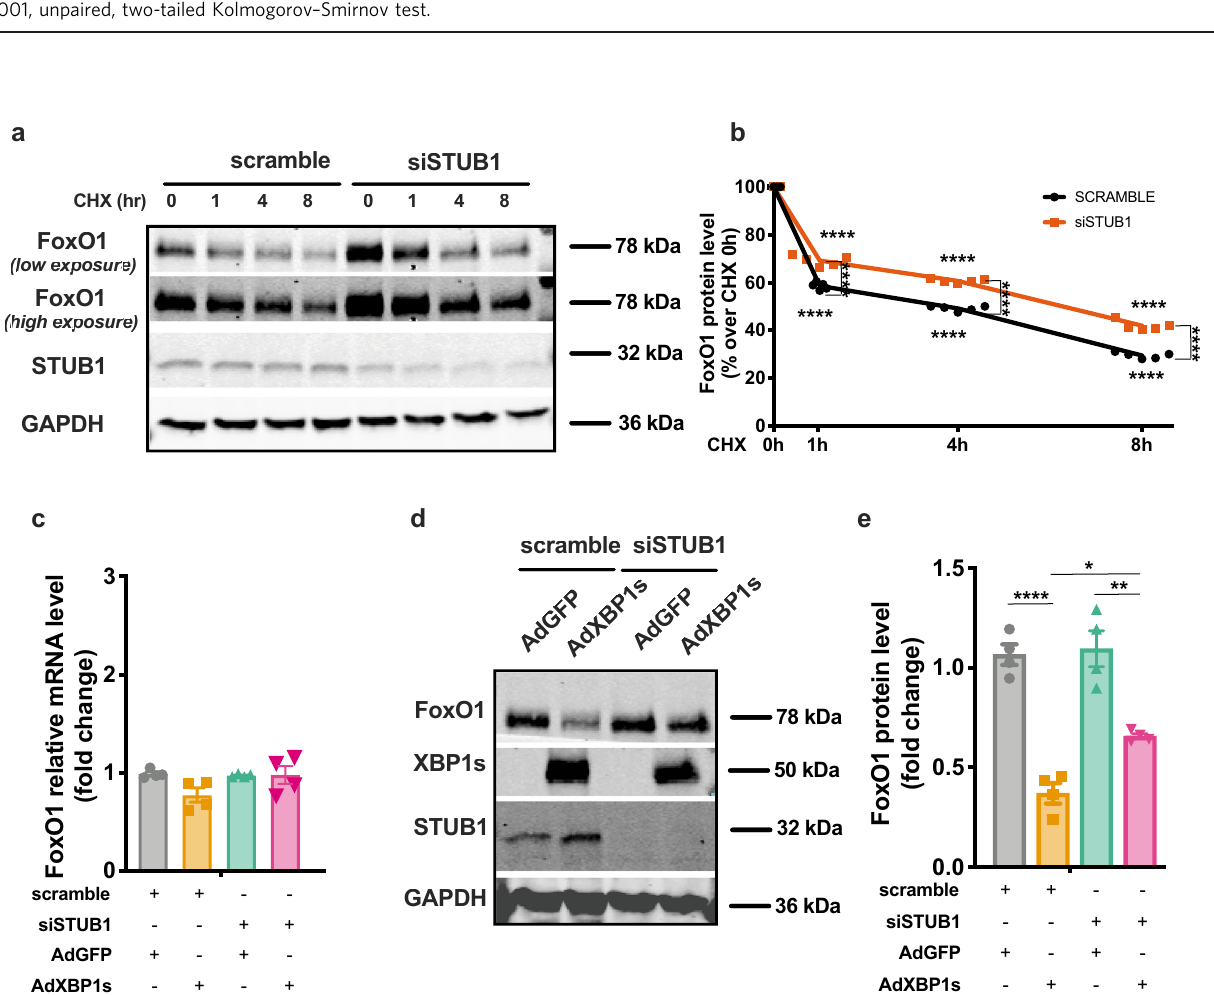
Fig. 4 STUB1 is a direct transcriptional target of Xbp1s. a Conserved consensus sequence of Xbp1s-binding site (unfolded protein response element — UPRE) in the promoter region of STUB1. 129 bp from the transcriptional start site (arrow). b Luciferase (Luc) activity in human embryonic kidney 293 cells (HEK293) transfected with STUB1-luciferase reporter construct (STUB1-Luc) and transduced with the increasing multiplicity of infection of AdGFP or AdXbp1s ( n = 6 biologically independent experiments). c Electrophoretic analysis of chromatin immunoprecipitation (ChIP) assay of STUB1 promoter in NRVMs transduced with AdGFP or AdXbp1s. ChIP was performed with either control mouse immunoglobulin G (IgG) or anti-Xbp1s antibody. PCR was conducted with primers spanning the UPRE site. Images are representative of 4 independent experiments. d Densitometric analysis of STUB1 ChIP band intensities in the different experimental groups ( n = 4 biologically independent experiments). e mRNA level of STUB1 in NRVMs transfected with STUB1- speci fi c small interfering RNA (siSTUB1) or scrambled siRNA control and transduced with AdGFP or AdXbp1s ( n = 4 biologically independent experiments). f Representative immunoblot images of Xbp1s, STUB1 and GAPDH proteins from NRVMs transfected with siSTUB1 or scrambled siRNA control and transduced with increasing multiplicity of infection of AdGFP or AdXbp1s. Images are representative of fi ve independent experiments. g Densitometric analysis of STUB1 protein band in the different experimental groups ( n = 5 biologically independent experiments). h Representative immunoblot images of Xbp1s, STUB1, and GAPDH proteins from LV of WT and Xbp1s TG mice. High and low exposure (high/low exp). Images are representative of six hearts/group. i Bar graphs depicting STUB1 protein band intensities in WT and Xbp1s TG LV samples ( n = 6/group). j mRNA level of XBP1s and STUB1 in LV of CTR and HFpEF hearts ( n = 4 for Xbp1s CTR group; n = 6 for the remaining groups). Results are presented as mean ± S.E.M. In b and e , * p < 0.05, ** p < 0.005, *** p < 0.0005, **** p < 0.0001, one-way ANOVA plus Sidak ’ s multiple comparisons test. In d , g , i , j ** p < 0.005, **** p < 0.0001, unpaired, two-tailed Kolmogorov – Smirnov test.